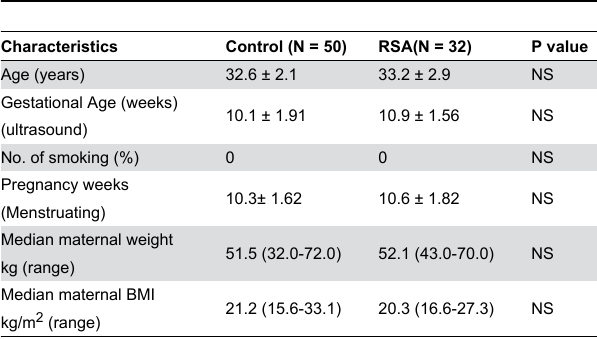
Table 1. Clinical Characteristics of